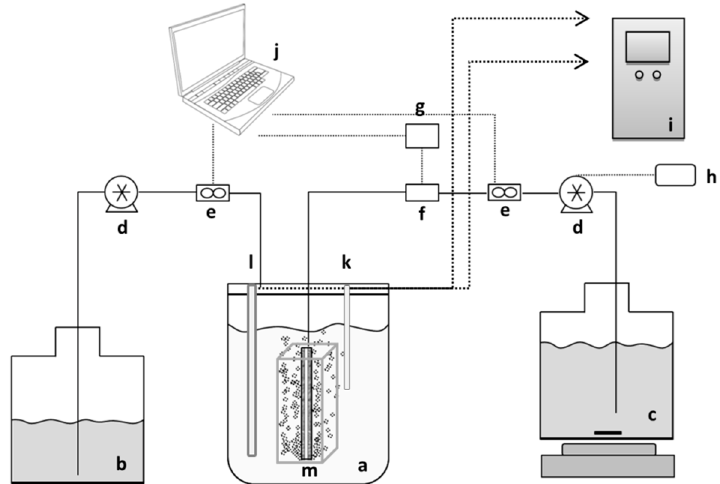
Figure 1. Immersed MBR setup: (a) iMBR (b) feed tank (c) permeate tank (d) pumps (e) flowmeters (f) pressure sensor (g) pressure sensor reader (h) relay (i) control unit (j) computer (k) pH electrode (l) temperature sensor (m) spacer box . * Units marked in italic are only present in the double panel setup.